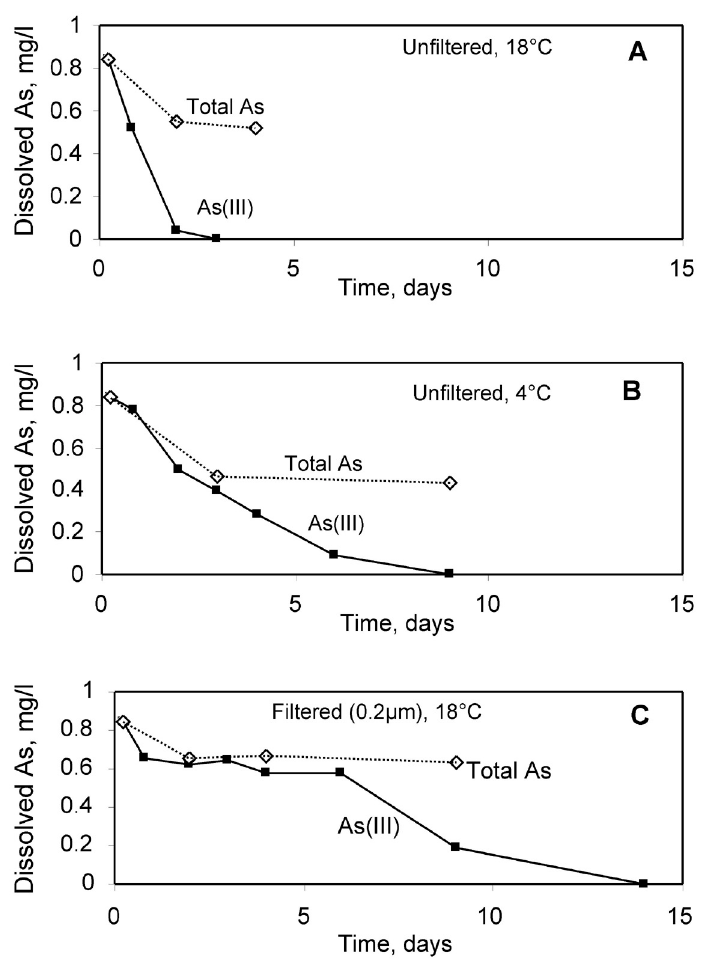
FIGURE 4. Experimental oxidation of As(III) with time in spring water from a Macraes historical adit: (A) unfiltered water, as collected, kept at 18 ° C; (B) unfiltered water kept at 4 ° C; (C) same water, filtered (0.2 µm) and kept at 18 ° C. filtration. The emerging water had ca. 0.8 mg/l dissolved As when it was sampled for this study. This dissolved As was essentially all As(III) in samples obtained at the emergence point.